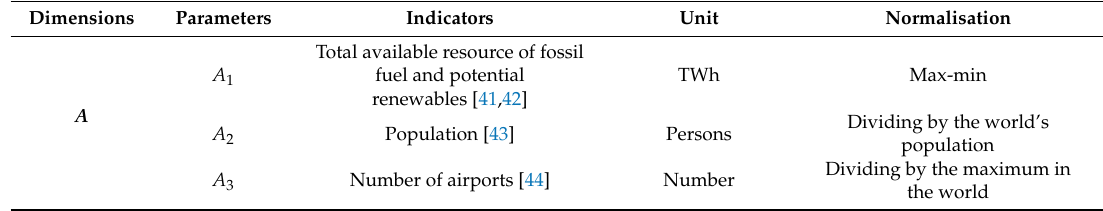
Table1. Energysecurityindicatorsformingtheparametersanddimensionsfortheenergysecurityindex.